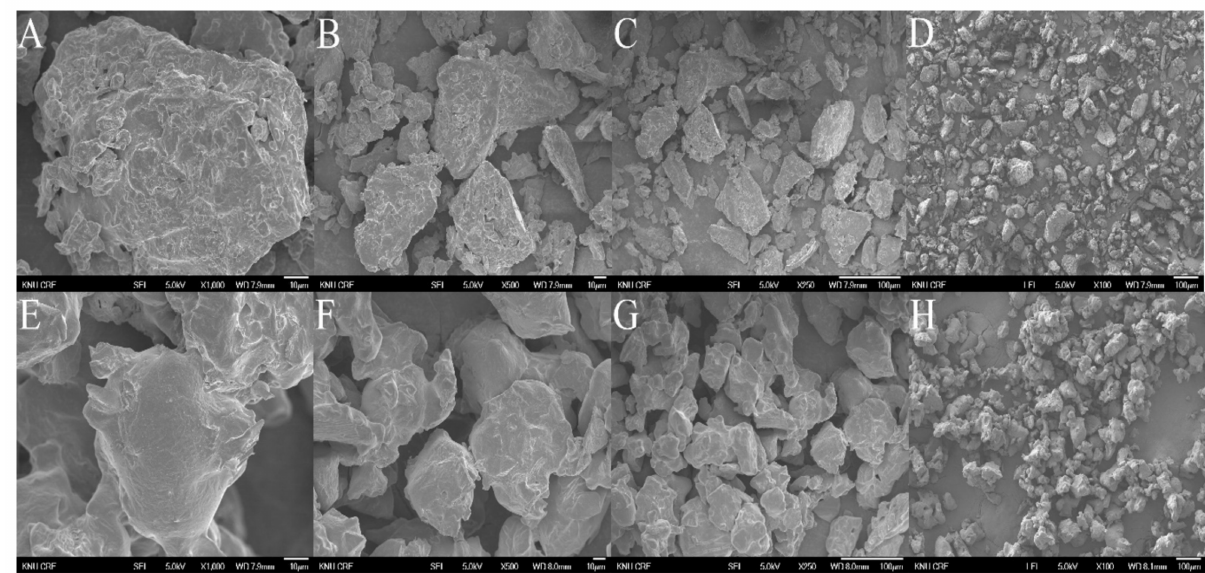
Figure 5. Scanning electron microscopy image of non-extrusion and extrusion. ( A – D ) MUL powder (MUL), ( × 1000, × 500, × 250, × 100), ( E – H ) solid formulations of the extrudate of MUL treated with 0.5 M citric acid and 0.3% sodium alginate (MUL-ESFs-CA-ALG), ( × 1000, × 500, × 250, ×